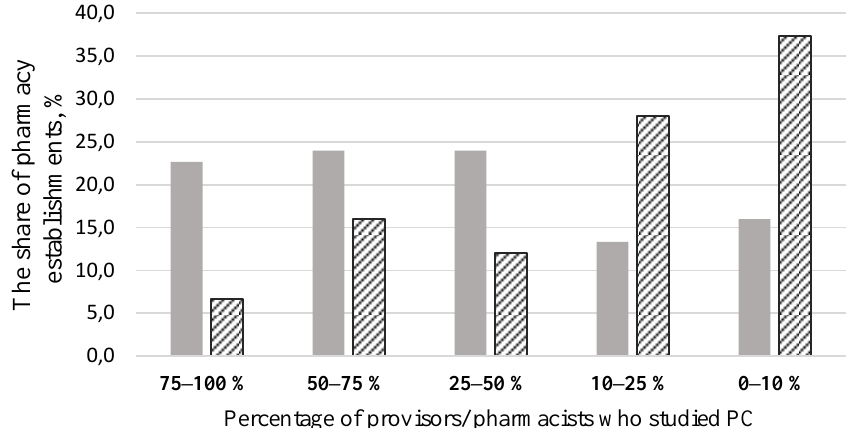
Fig. 5. Distribution of pharmacies by the number of provisors and pharmacists who studied pharmaceutical care